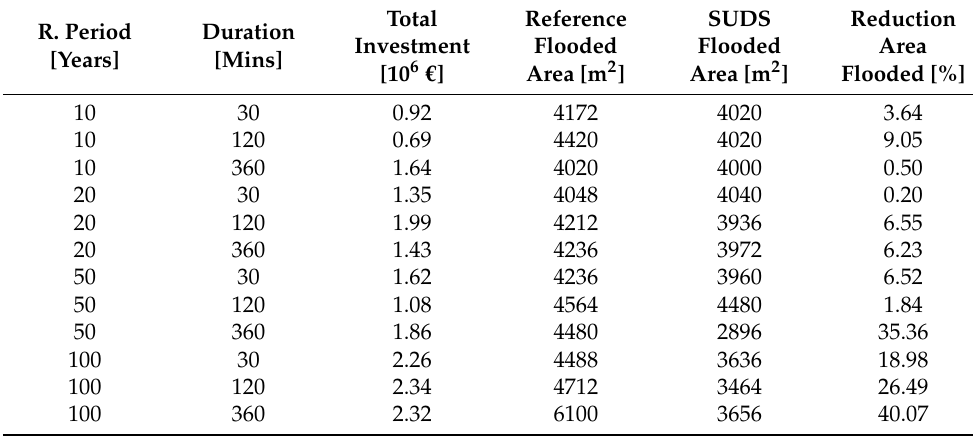
Table 8. Reference areas flooded and SUDS performance reducing these areas. R.